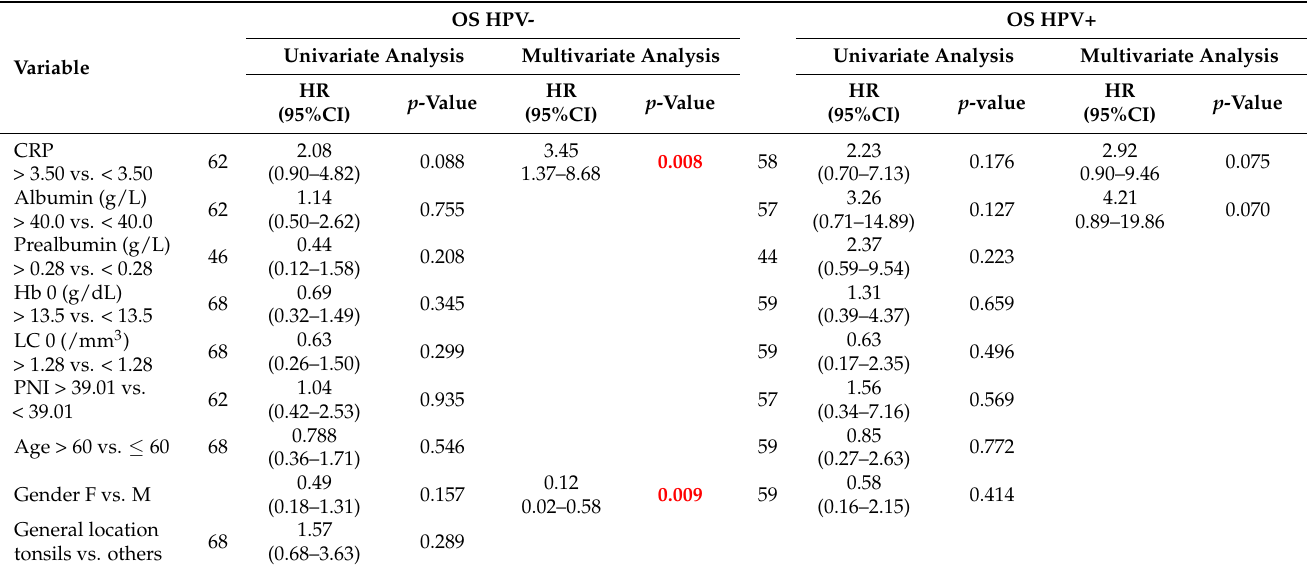
Table 6. Overall survival (OS) in HPV-/HPV+ patients: univariate and multivariate analysis.